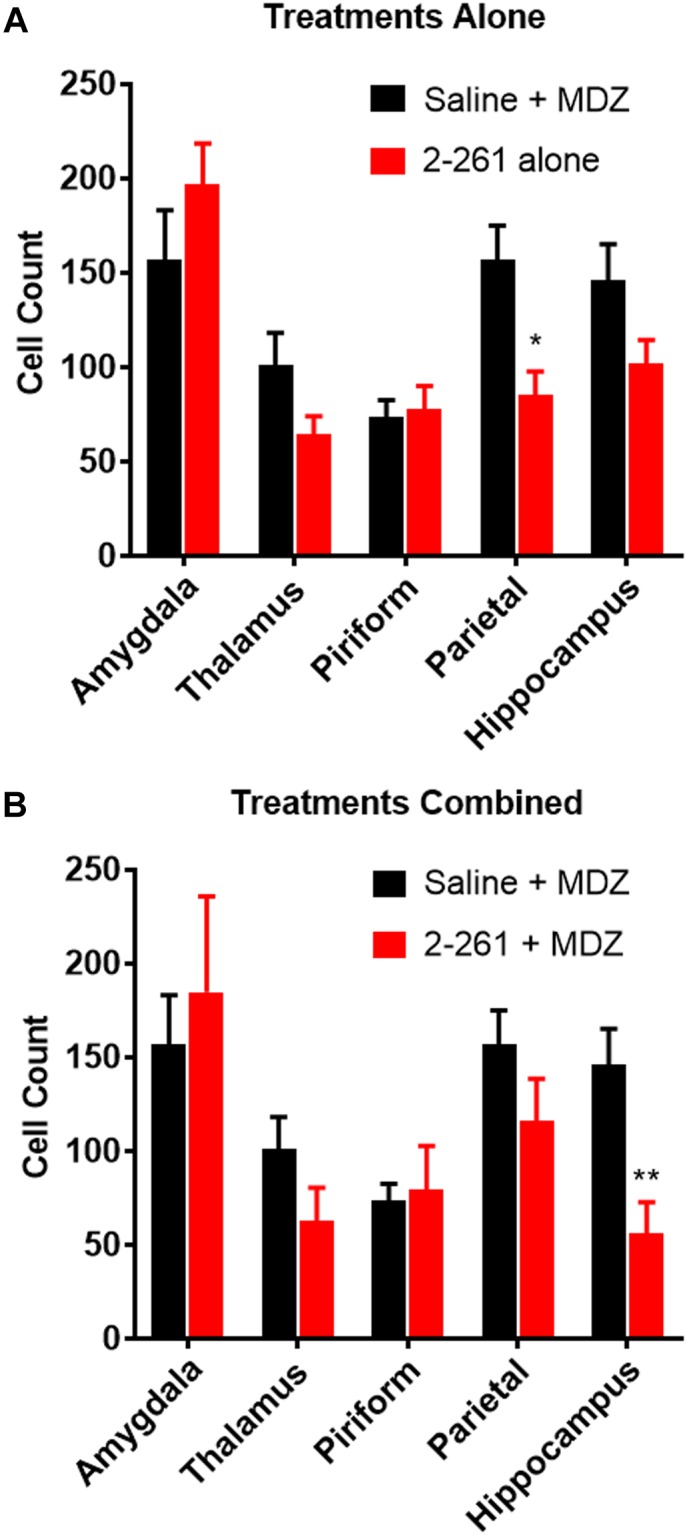
Effect of treatment by 2-261 alone (A) or combined with MDZ (B) on Fluoro-Jade B labeled neurons in various brain regions removed from subject rats 4 h after receiving soman (180 μg/kg, s.c.) challenge. Asterisks indicate brain regions in which there was a significantly different response (∗p < 0.05, ∗∗p < 0.01) between treatment groups in the number of Fluoro-Jade B stained neurons as measured by t-test, N = 9–10 rats for each treatment group. MDZ, midazolam.